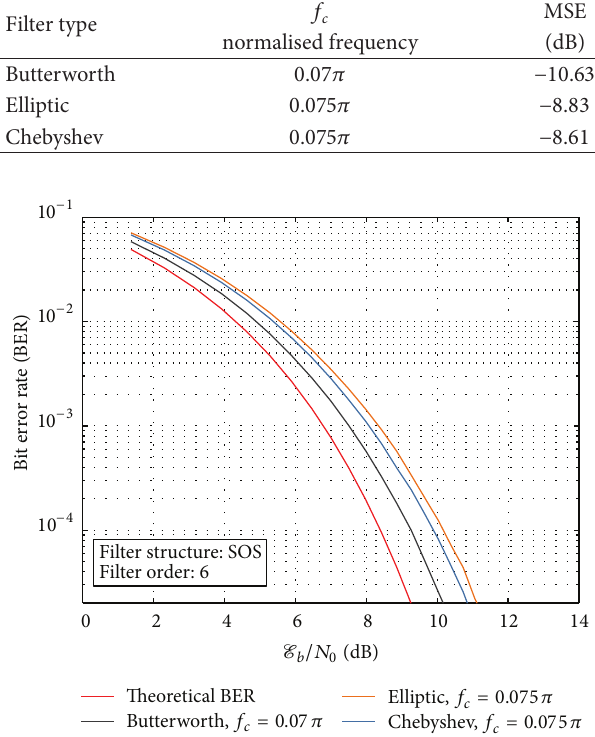
Figure 3: Transceiver BER for a Butterworth, elliptic, and Cheby- shev filters based on the exemplary communication system model (Figure 1). All filters are designed with order 6. The simulation is done for 𝑁 𝑏 = 10 6 bits.